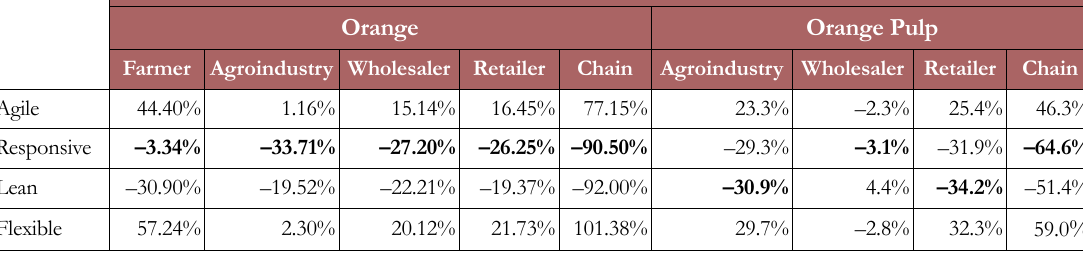
Table 7b. Percentage Change inventory for Orange